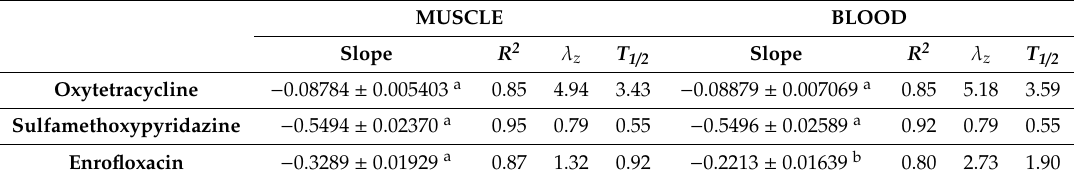
Table 1. Half-lives of elimination ( T 1 / 2 ) calculated (Equation (1)) for oxytetracycline, sulfamethoxypyridazine, and enrofloxacin, expressed in days.